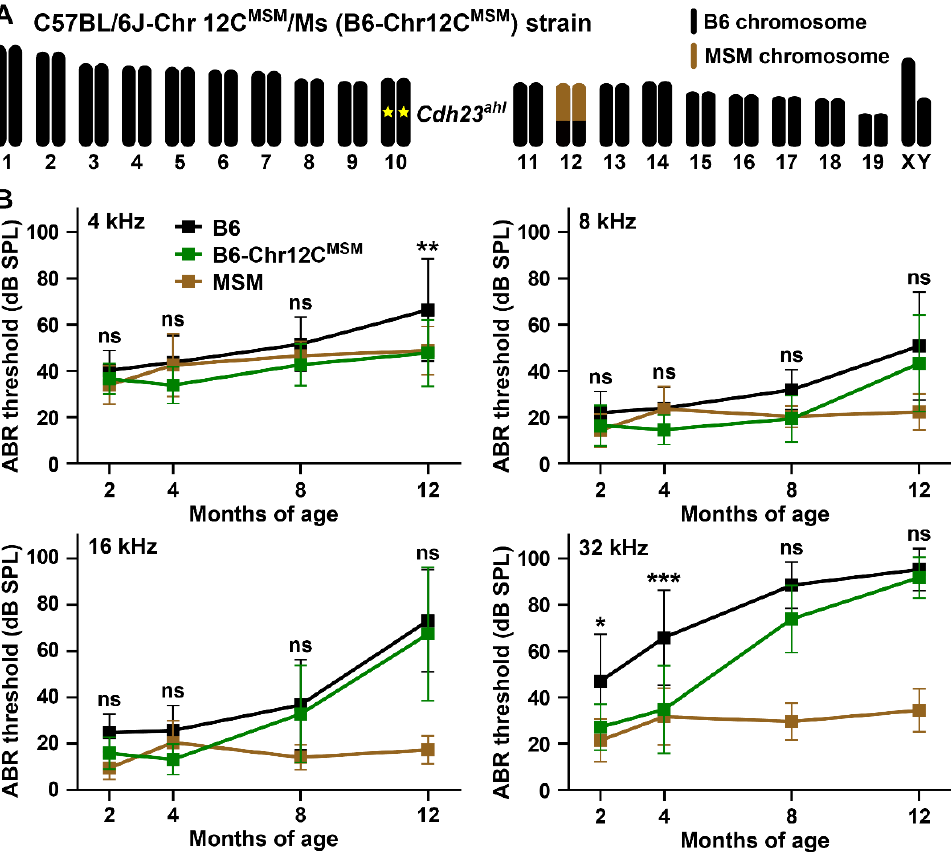
Figure 8. The C57BL/6J-Chr 12C MSM /Ms (B6-Chr12C MSM ) subconsomic strain exhibits delayed ARHL onset: ( A ) Schematic chromosomal structure of a B6-Chr12C MSM strain. A yellow star on chromosome 10 indicates Cdh23 ahl allele. Light brown color indicates a transferred MSM-derived ~71 Mb chromosomal region. ( B ) Comparison of the ABR thresholds at 4, 8, 16, and 32 kHz sound stimuli among male mice of the B6, MSM, and B6-Chr12C MSM strains at 2 (B6, n = 15; MSM, n = 12; B6-Chr12C MSM , n = 10), 4 (B6, n = 15; MSM, n = 15; B6-Chr12C MSM , n = 10), 8 (B6, n = 14; MSM, n = 11; B6-Chr12C MSM , n = 12), and 12 (B6, n = 15; MSM, n = 14; B6-Chr12C MSM , n = 11) months of age. The means (squares) and SDs (error bars) of the ABR thresholds are shown. Two-way ANOVA revealed significant strain effects between B6 and B6-Chr12C MSM strains of the ABR thresholds at all frequencies (Table S11). The asterisks and “ns” symbols indicate significant (* p < 0.05, ** p < 0.01, and *** p < 0.001) and no significant differences, respectively, between the ABR thresholds of the B6 and B6-Chr12 MSM strains at the same age in each graph, determined using Sidak’s (4, 8, and 16 kHz) and Tukey’s (32 kHz) multiple comparison tests after two-way